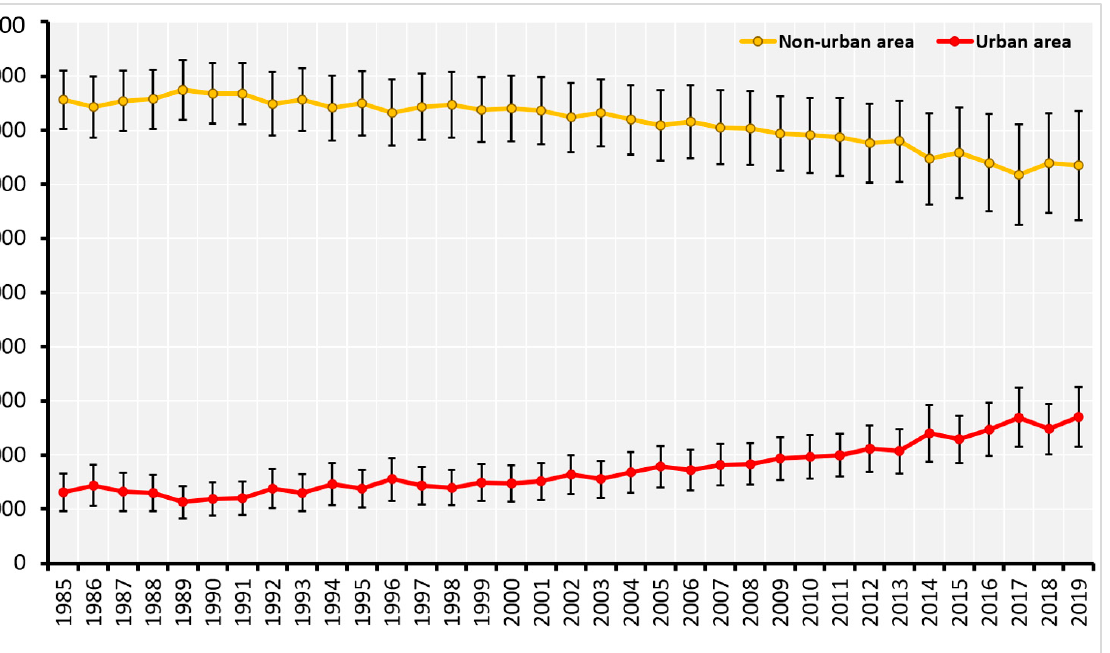
Figure 6. The user’s, producer’s, and overall accuracies from 1985 to 2019 (95% confidence intervals are represented by the error bars for overall accuracy).